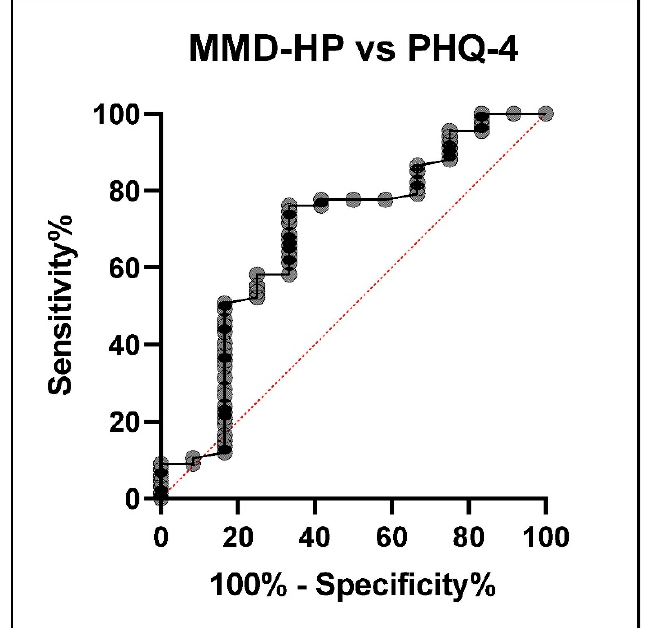
Figure 4. ROC curve of the MMD-HP score versus depression and/or anxiety symptoms in ICU nurses.